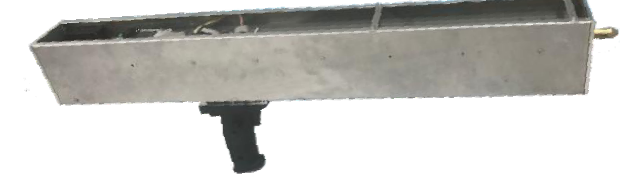
Figure 2. The microdestructive tree-ring measurement system.